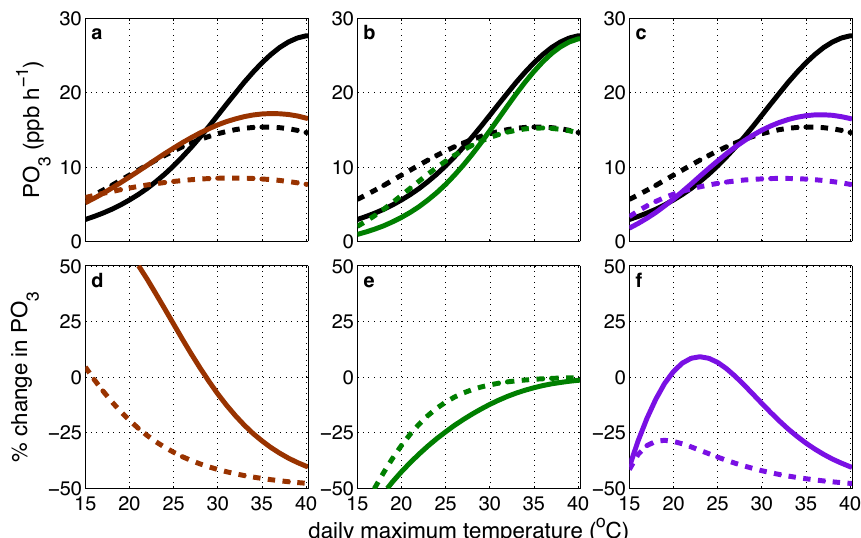
Fig. 7. (a–c) P O 3 (ppb h − 1 ) on weekdays (solid line) and weekends (dashed line) versus daily maximum temperature ( ◦ C) calculated with CalNex-SJV observations (black) and in (a) with a 50% NO x reduction (brown), in (b) with a 50% reduction in the temperature-independent 6 i VOCR i (green), and in (c) with both reductions applied (purple). (d–f) the percent change between P O 3 on weekdays (solid line) and weekends (dashed line) during CalNex-SJV and that computed after emission reduction versus daily maximum temperature ( ◦ C).